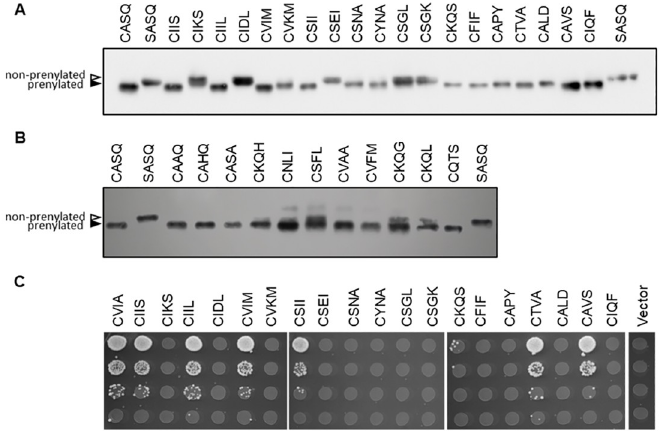
Fig 3. Empirically determined prenylation and cleavage of various Cxxx sequences. Yeast strains lacking chromosomally encoded YDJ1 (yWS304 or yWS2544, ydj1 Δ ) or MFA1 and MFA2 (SM2331, mfa1 Δ mfa2 Δ ) were engineered to individually express the indicated Ydj1p-Cxxx or a -factor-Cxxx variant, respectively, using a plasmid- based expression system. Prenylation of the indicated naturally occurring Cxxx sequences in yeast (A) or global Cxxx sequences (B) were determined by Ydj1p-gel shift assay. Yeast extracts were evaluated by SDS-PAGE and anti-Ydj1p immunoblot to reveal prenylated (closed triangle) and non-prenylated sequences (open triangle). Partial prenylation (i.e., doublet bands) were counted as a positive result. C) Cleavage of the indicated Cxxx sequences was determined by the a -factor mating assay. MAT a yeast cultures were serial diluted 10-fold in the presence of excess MAT α yeast (IH1793) and plated on SD media. Mating is indicated by diploid growth and is reported relative to mating exhibited by wildtype a -factor